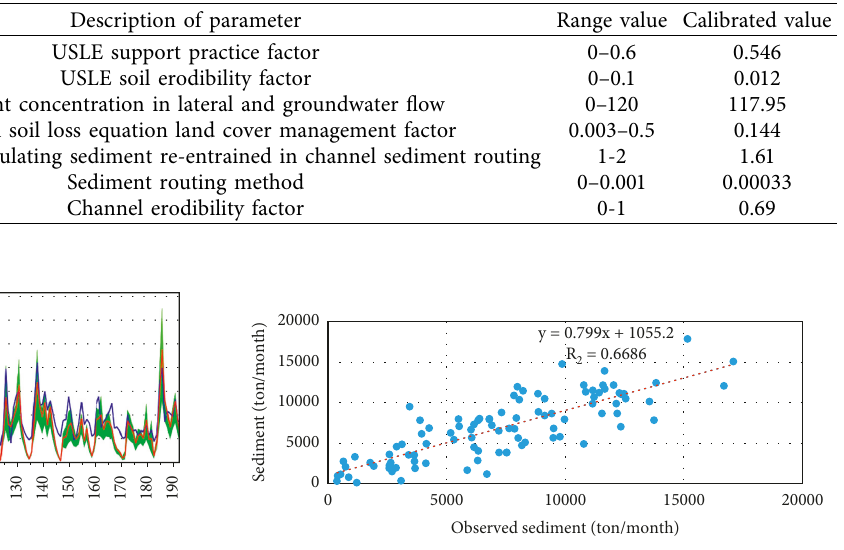
Figure 13: Scatter plot of sediment yield for the validation period